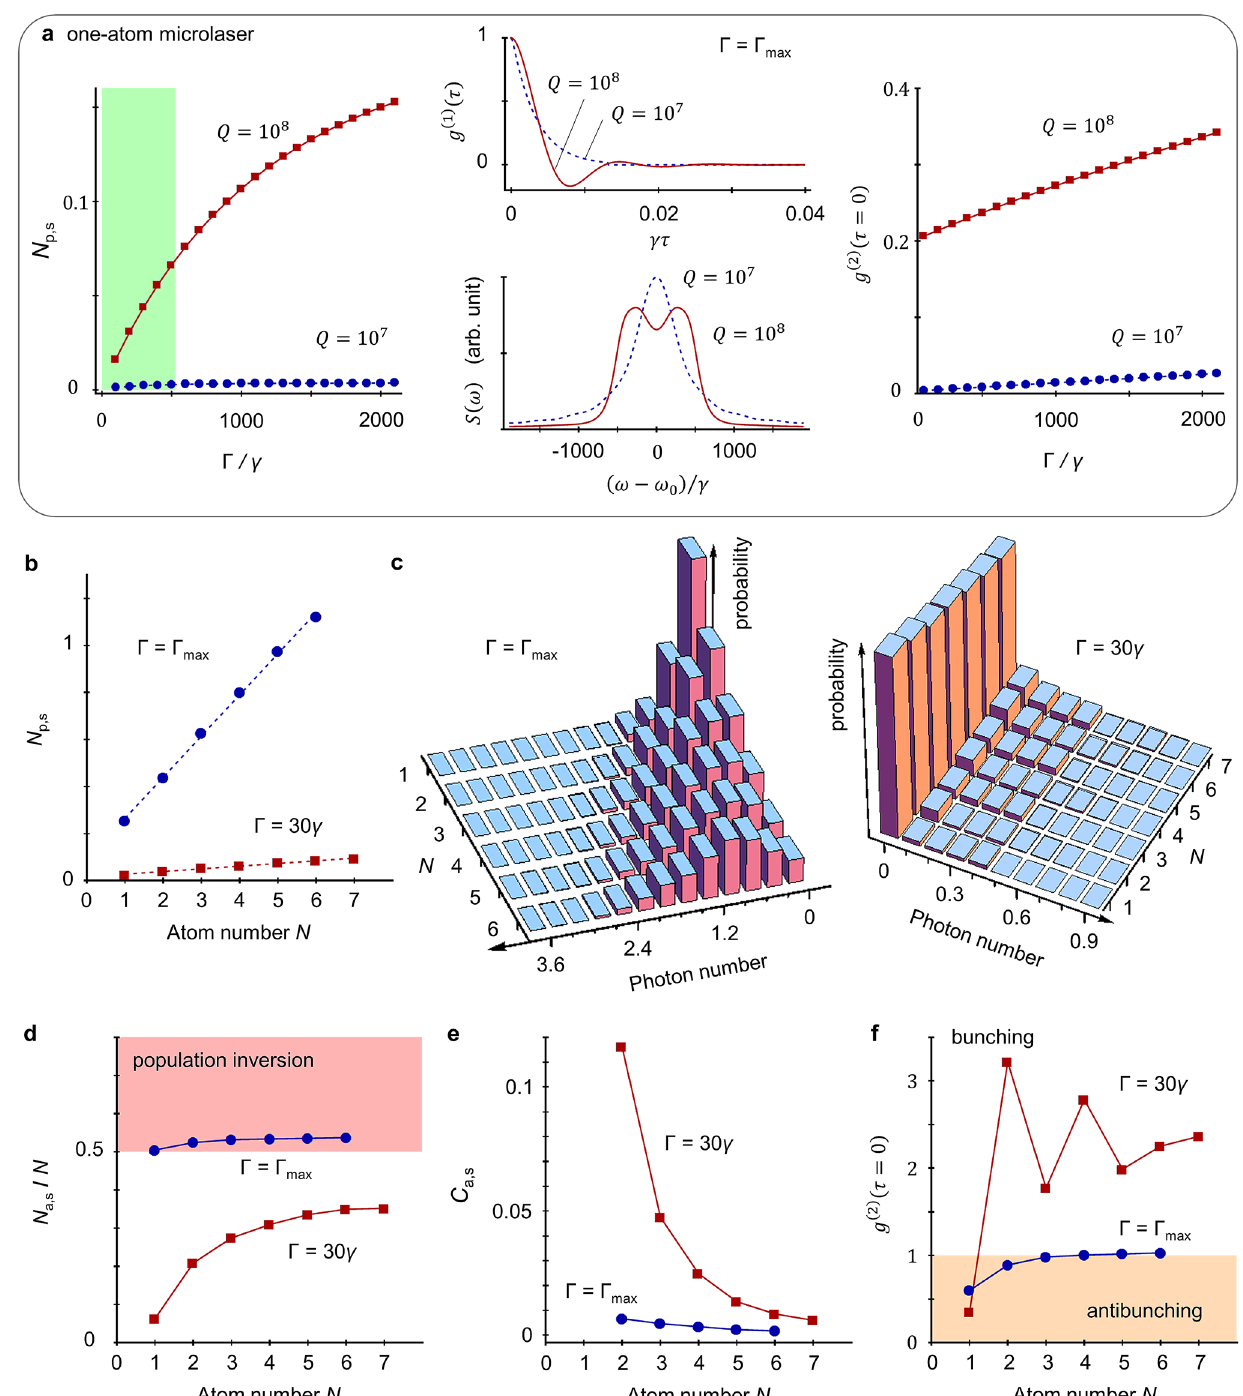
Figure 4. Microlasing action. ( a ) Steady-state intracavity photon number N p,s as a function of the pump rate Γ, first-order correlation g ( 1 ) (τ) and laser spectrum S (ω) at the maximum pump Γ = Γ max , and zero-time-delay 0 ) of one-atom microlaser with N = 1. For the low- Q microcavity with Q 10 7 , intensity correlation g ( 2 ) (τ = = the linewidth (full width half maximum) of S ( ω ) is about 633 γ , much smaller than the intrinsic decay rate κ of 10 8 , the spectral linewidth of either peak in S (ω) is evaluated by WGMs. For the high- Q microcavity with Q = θ) with the amplitude A , linewidth (cid:31) , frequency shift δ and phase Ae − �τ/ 2 cos (δτ fitting the function G (τ) = + 475 γ , less than the decay rate κ of bias θ to the corresponding g ( 1 ) (τ) . The resultant linewidth is given by � = WGMs. ( b ) N p,s as a function of the atom number N with Γ = Γ max (filled circle symbol) and 30 γ (filled square ( 0.18, 0.1 ) kN b , where ( k , b ) symbol). The dashed lines correspond to the linear curve-fitting results N p , s = + = ( 0.011, 0.016 ) for Γ = 30 γ . ( c ) Distribution of intracavity photon number for different N . for Γ = Γ max and ( k , b ) = P ( d ) Dependence of -population N a,s on the atom number N . ( e ) Interatomic correlation C a,s vs N . ( f ) Intensity | � 0 ) changing with N . For ( b – f ), the quality factor of microsphere is Q 10 8 correlation g ( 2 ) (τ = =